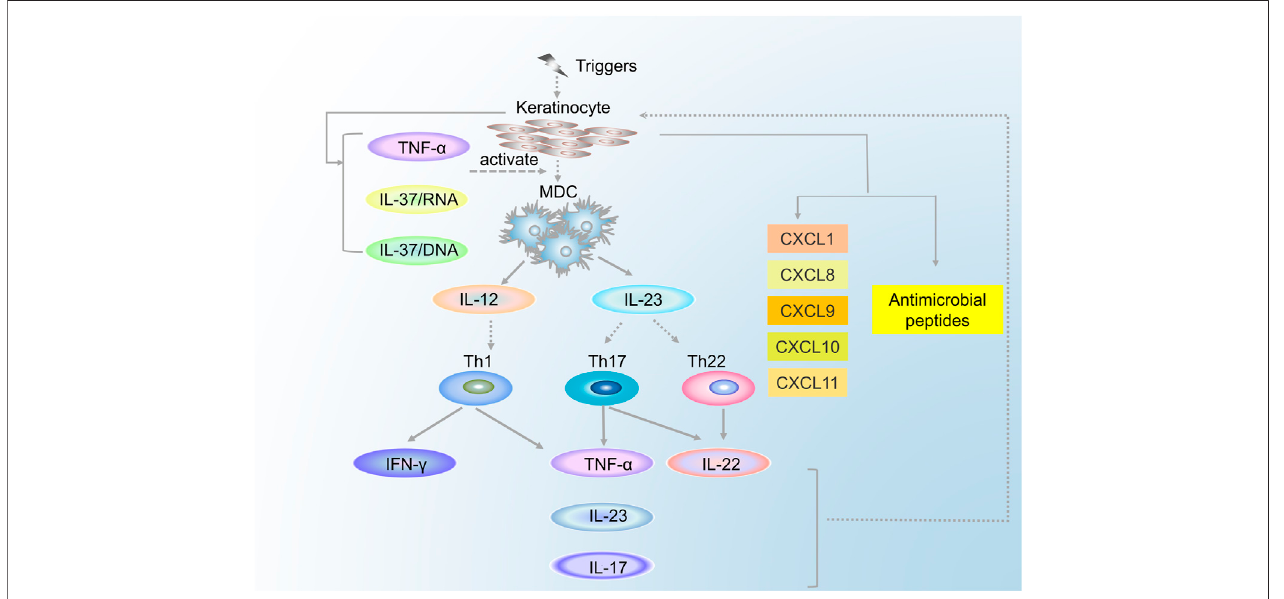
FIGURE 2 | The relationship between the MDCs and the T